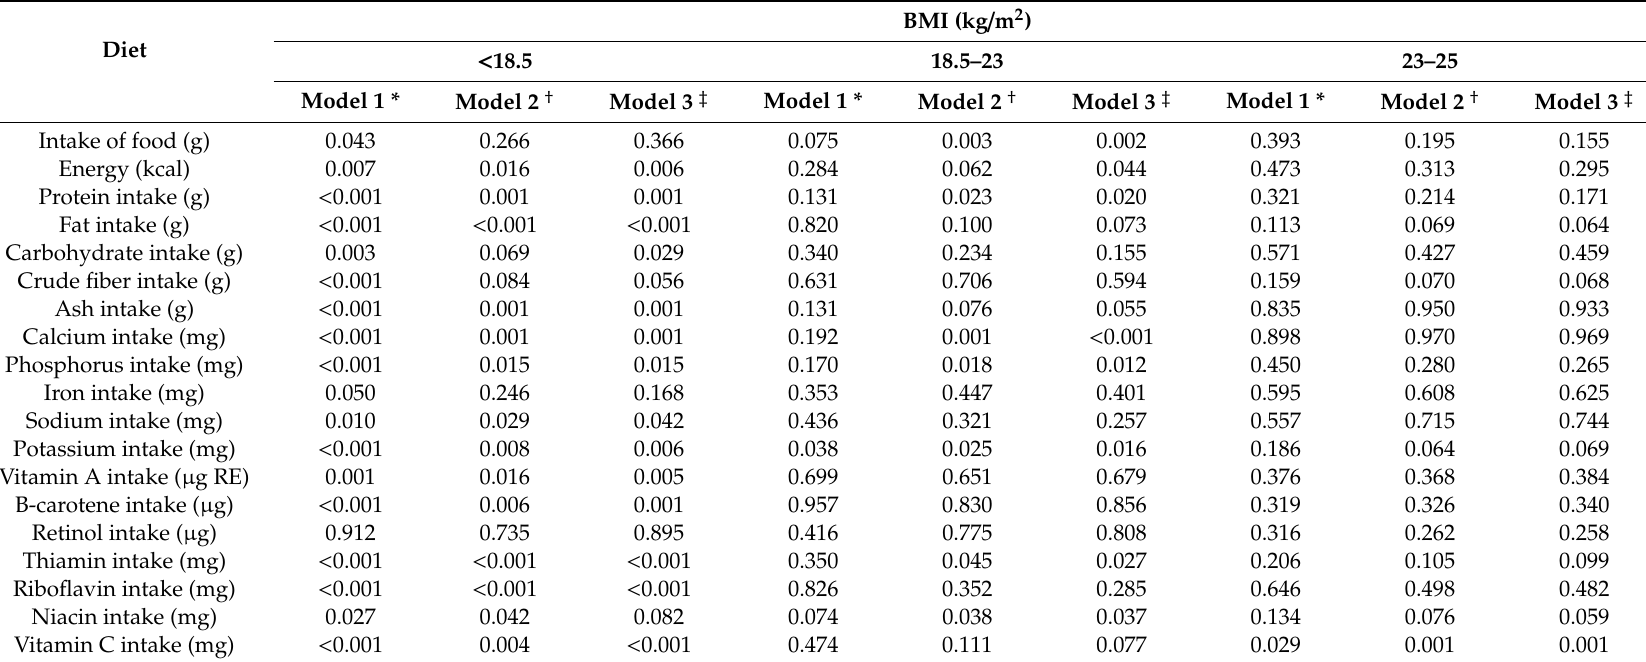
Table 3. Dietary intake between primary open angle glaucoma (POAG) and non-glaucoma group in females grouped by